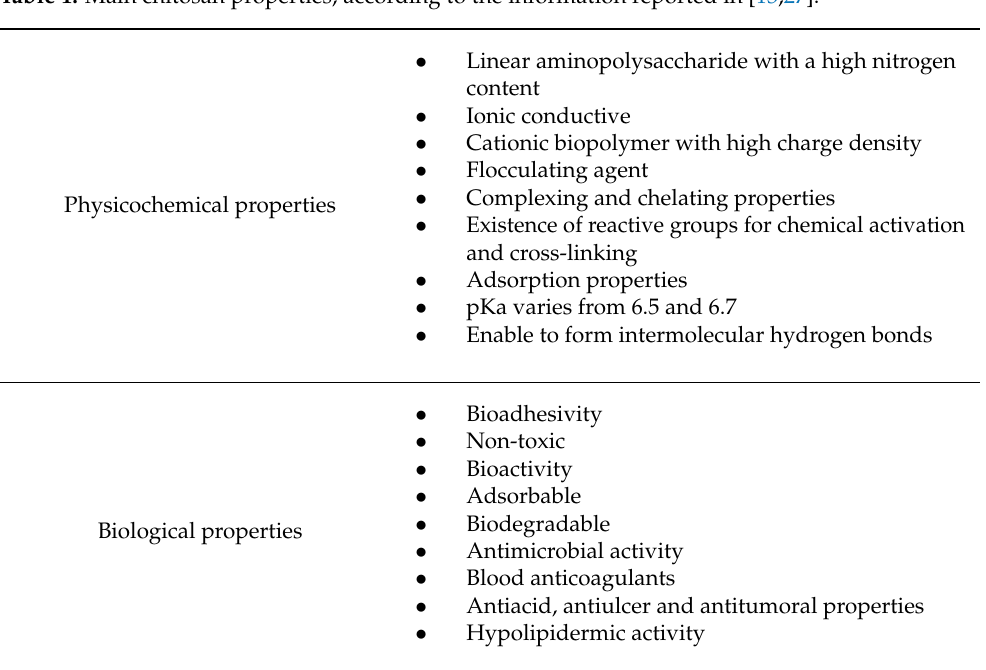
Table 1. Main chitosan properties, according to the information reported in